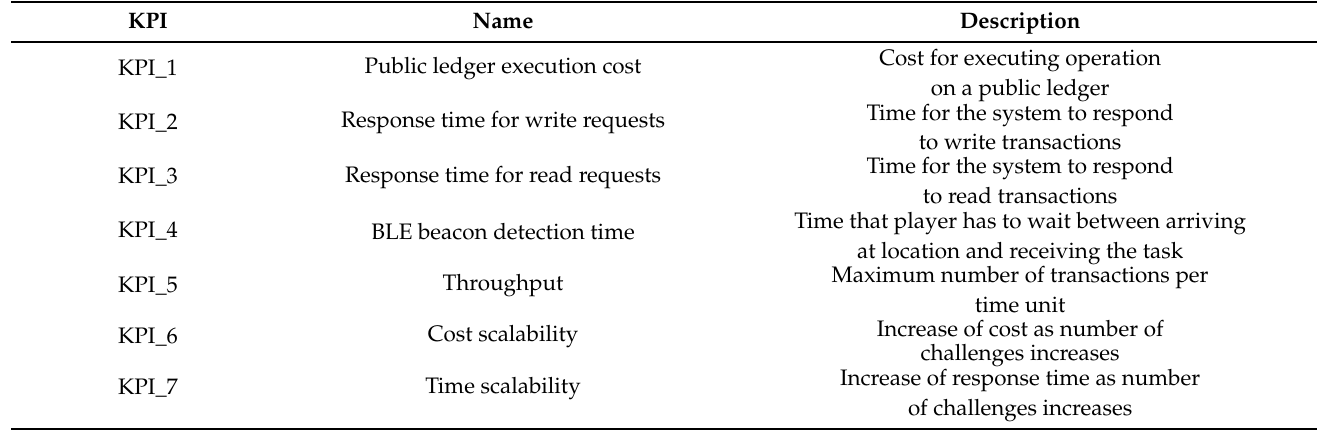
Table 1. System key performance indicators for the mobile